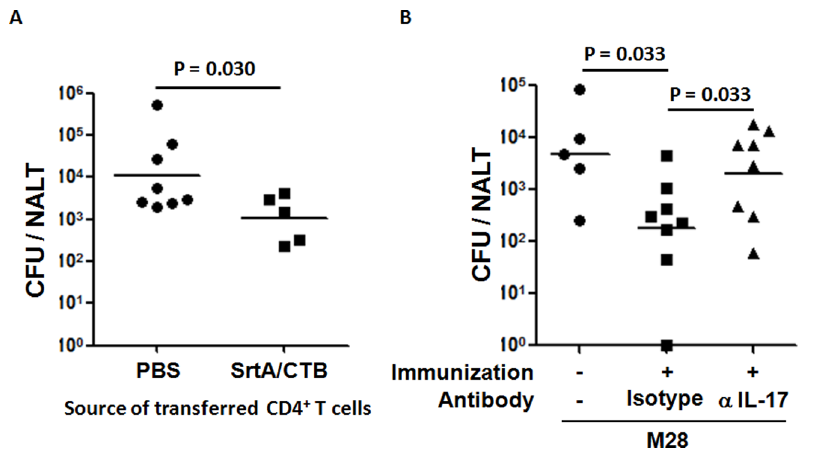
Figure 5. CD4 + IL-17A + T cells promoted clearance of GAS from NALT. ( A ) C57B/6 mice were immunized with SrtA/CTB three times and euthanized 10 days later. Single-cell suspensions of lymph nodes and spleens were pooled and CD4 + T cells were purified then transferred to naı¨ve WT C57B/6 mice. 24 hr after transfer recipients were challenged i.n. with M28 strain and euthanized 24 hr later for CFUs in NALT. ( B ) SrtA/CTB immunized mice received IL-17A neutralizing antibody or isotype control antibody i.p. several times prior to challenge with M28 strain. 24 hr after challenge mice were euthanized and NALT cell suspensions were plated for CFUs.